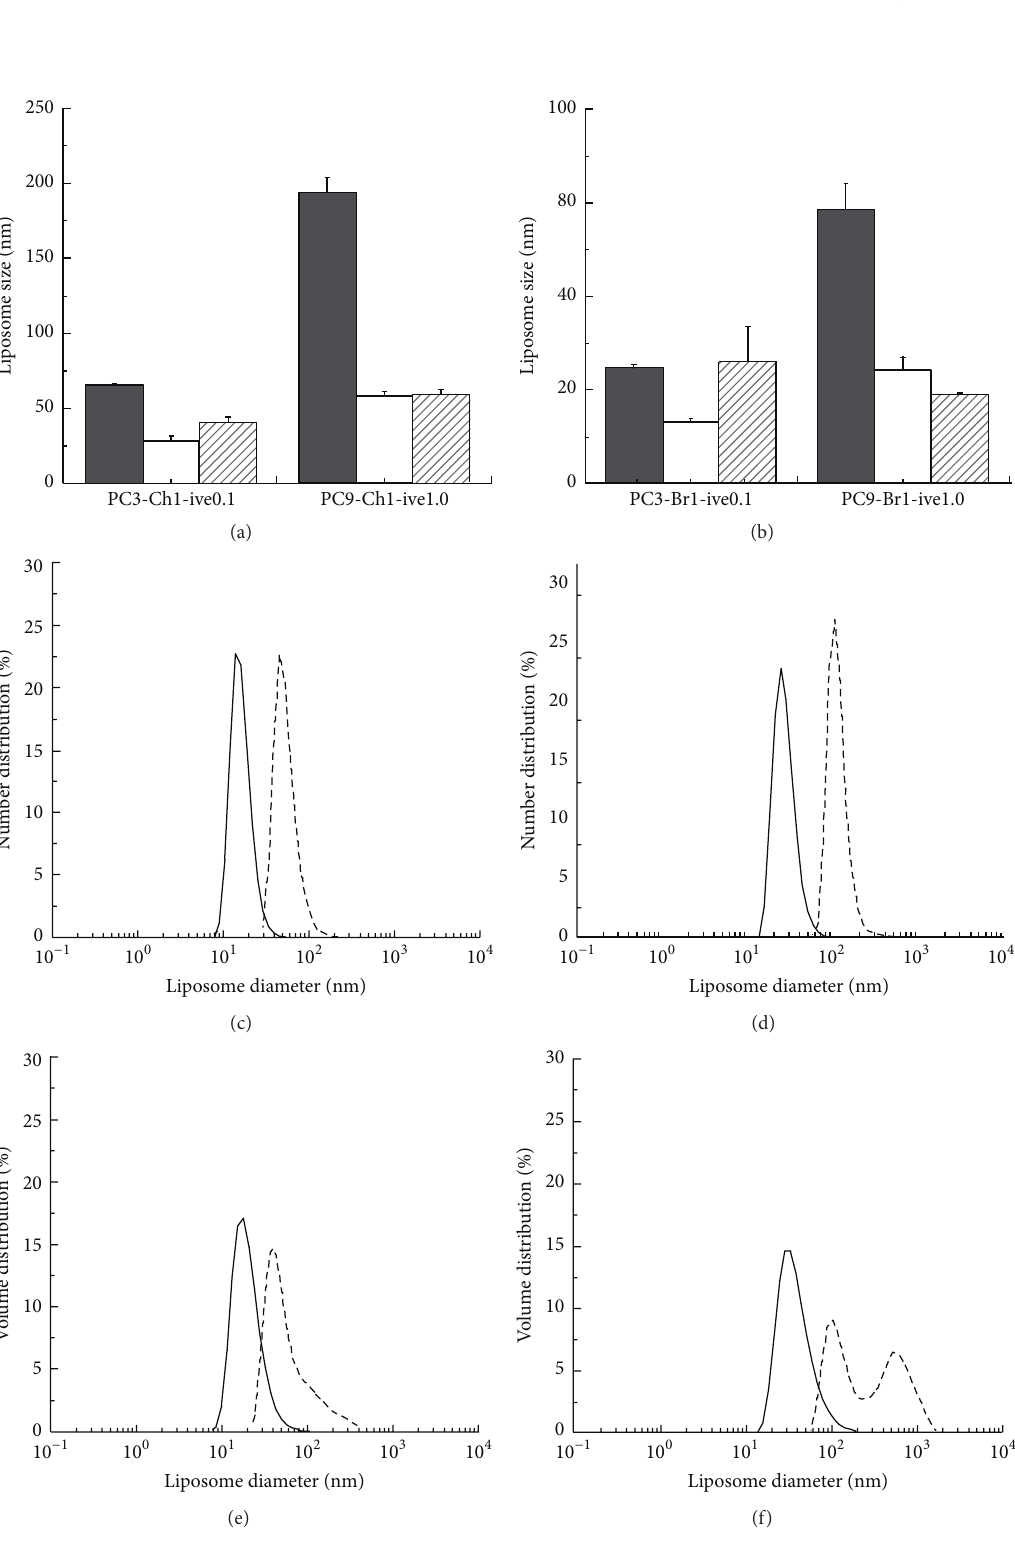
Figure 4: Effect of PC content and liposomal composition on mean diameters ((a), (b)) and size distribution ((c)–(f)) of the indicated ivermectin formulations. Bars in (a) and (b) correspond to 𝑍 -average (filled bars), mean by number (open bars), and mean by volume (striped bars). Curves in (c) and (e) correspond to #PC3-Ch1-ive0.1 (plain lines) and #PC9-Ch1-ive1.0 (dashed lines) liposomes; curves in (d) and (f) correspond to #PC3-Br1-ive0.1 (plain lines) and #PC9-Br1-ive1.0 (dashed lines)